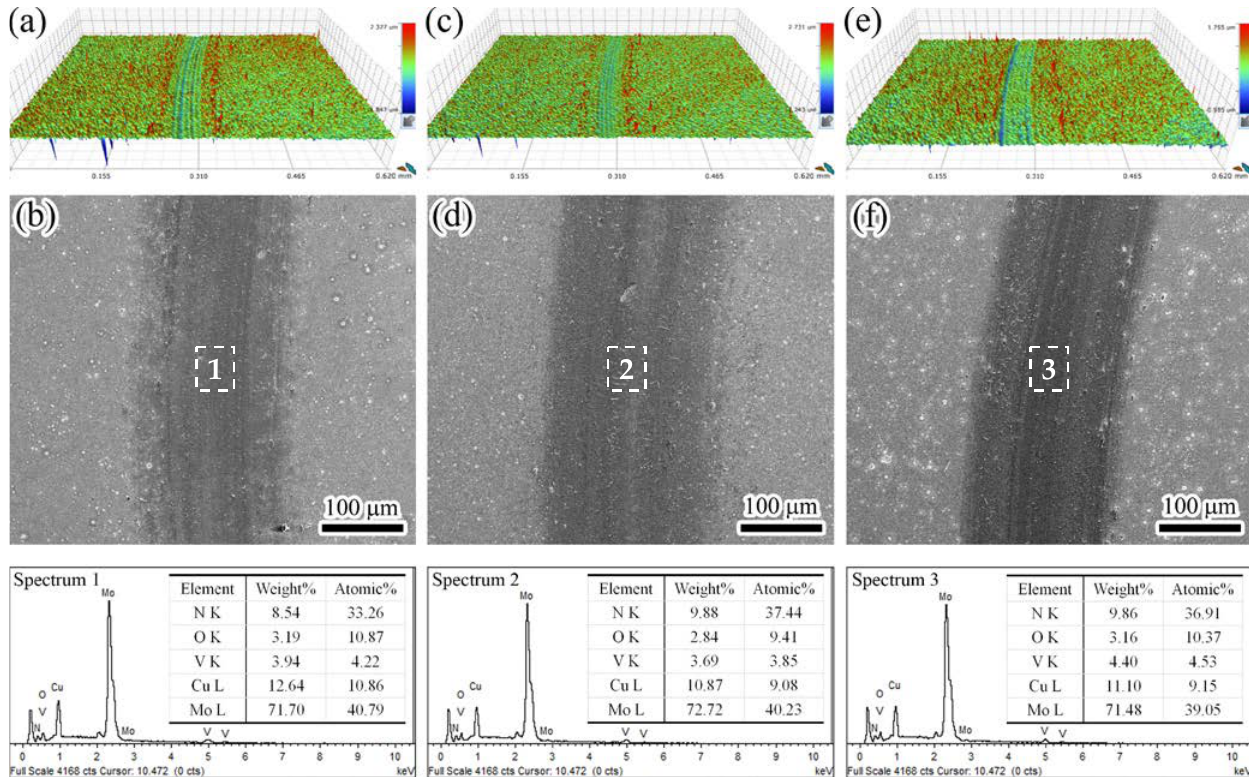
Figure 11. Three-dimensional morphologies, surface micrographs, and EDS results of the selected wear tracks: ( a , b ) 650 V, ( c , d ) 750 V, and ( e , f ) 850 V.